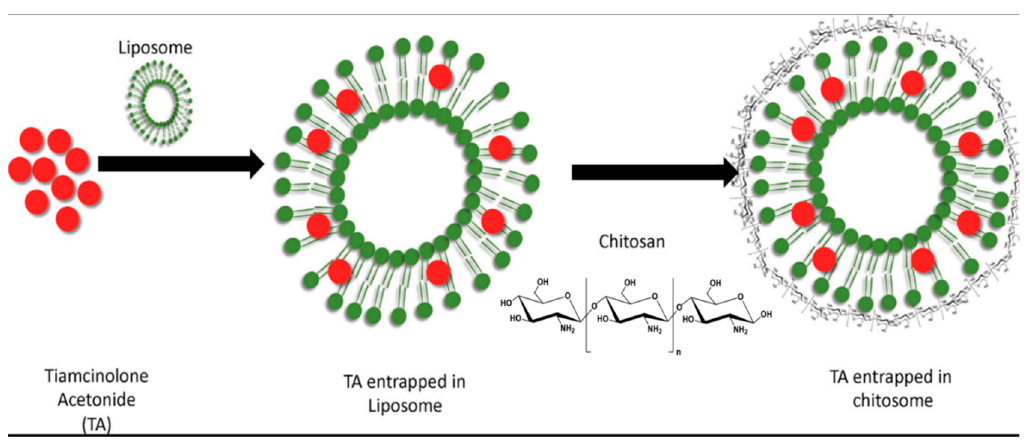
Figure 7. Schematic of chitosan coated liposomes. Adapted with permission from [76], Int. J. Biol. Macromol. 2020.